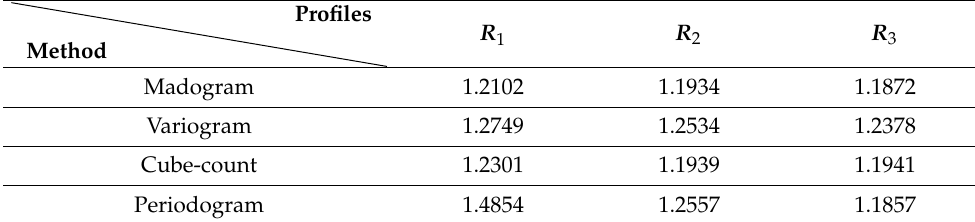
Table 7. Fractal dimension